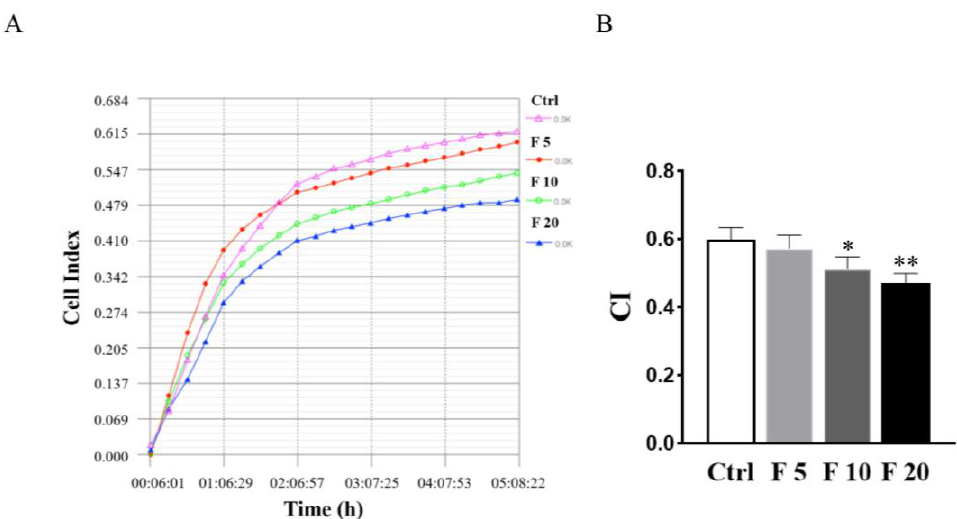
Figure 5. Effects of FST on adhesion of primary cultured trophoblasts of mice. ( A ) The cell adhesion was examined by RTCA in primary cultured mice trophoblasts subject to FST for 5 h. ( B ) The graph showed the average cell index (CI) and standard deviation ( n = 3). Ctrl: 2% FBS culture medium control. F5: 5 ng/mL of FST. F10: 10 ng/mL of FST. F20: 20 ng/mL of FST. * p < 0.05, ** p < 0.01 compared with control.